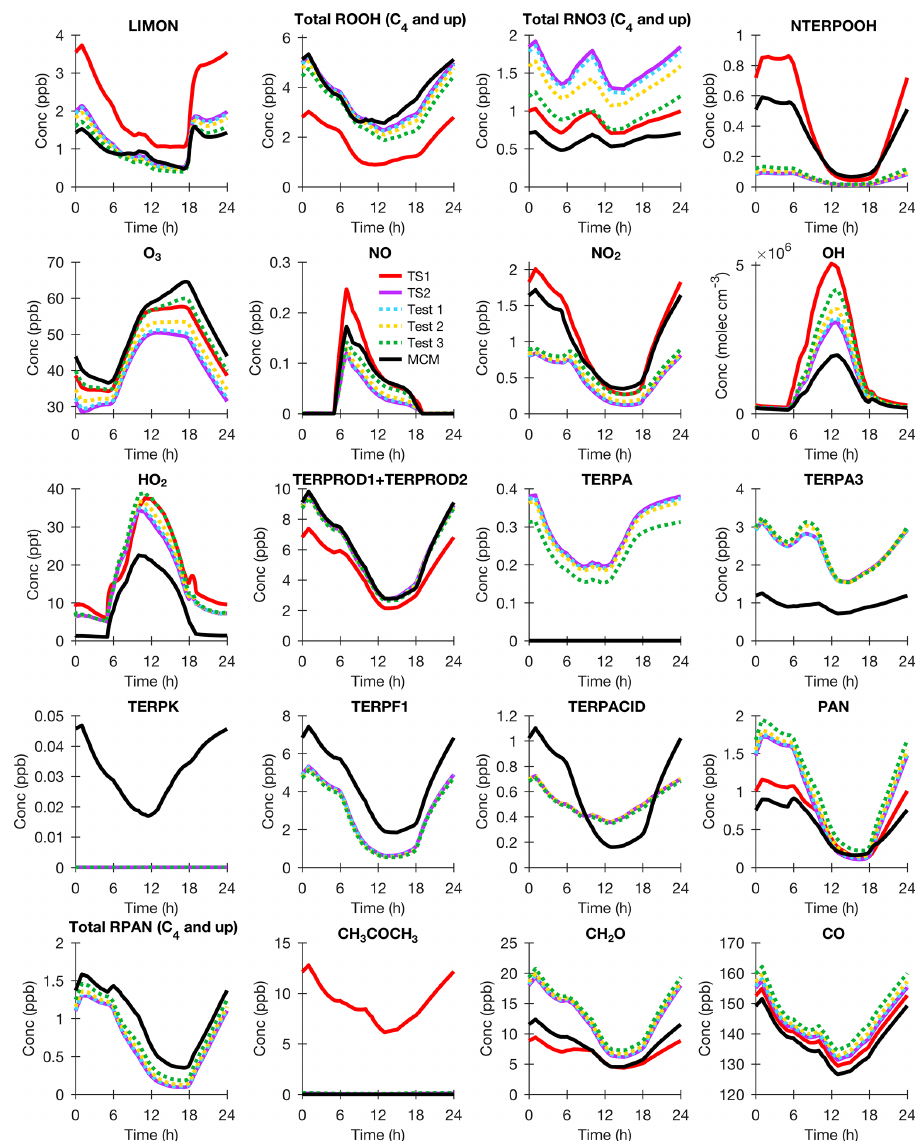
Figure 6. BOXMOX results for limonene (LIMON) oxidation using TS1 (red), MCM (black), TS2 (purple), TS2 with MCM pinonaldehyde nitrate yield (blue; Test 1), TS2 with MCM pinonaldehyde and limonaldehyde nitrate yield (gold; Test 2), and TS2 with MCM pinonaldehyde and limonaldehyde nitrate yield and assumptions for oxidation of unsaturated hydroxy nitrates (green; Test 3). The model configuration is explained in Sect. 3.1. All species names are identical to Fig.